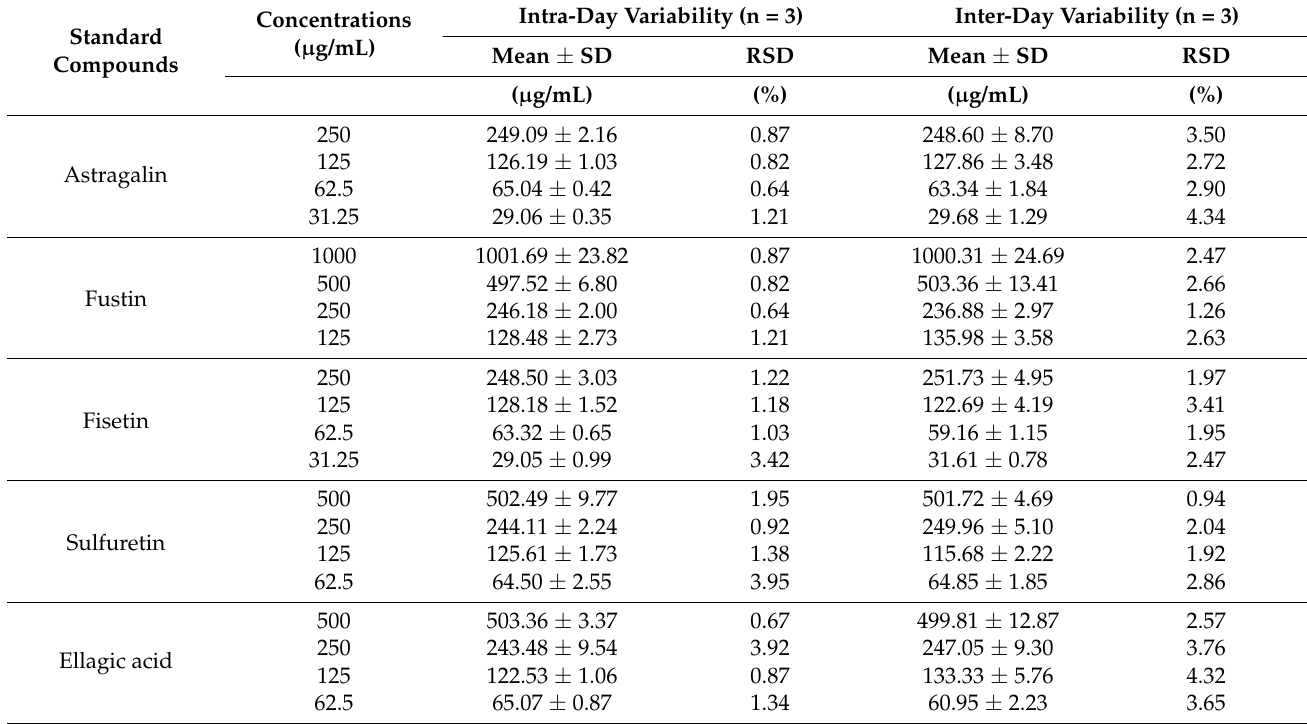
Table 2. Analytical results of intra-day and inter-day variability.